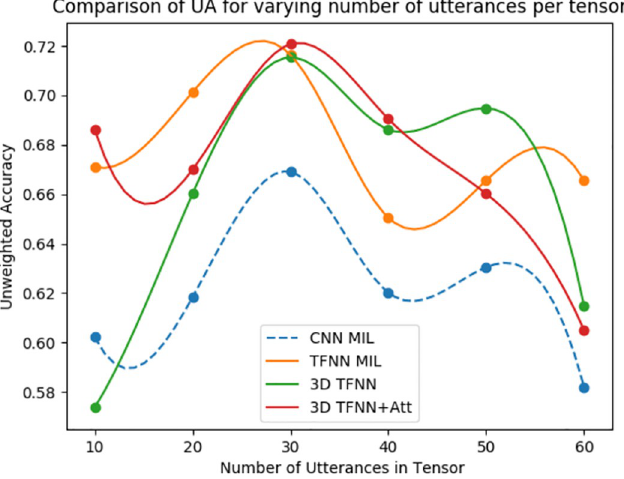
Fig 4. Comparison of unweighted accuracy for varying number of utterances per tensor for the architectures CNN-MIL, TFNN-MIL, 3D TFNN and 3D TFNN+Attention.